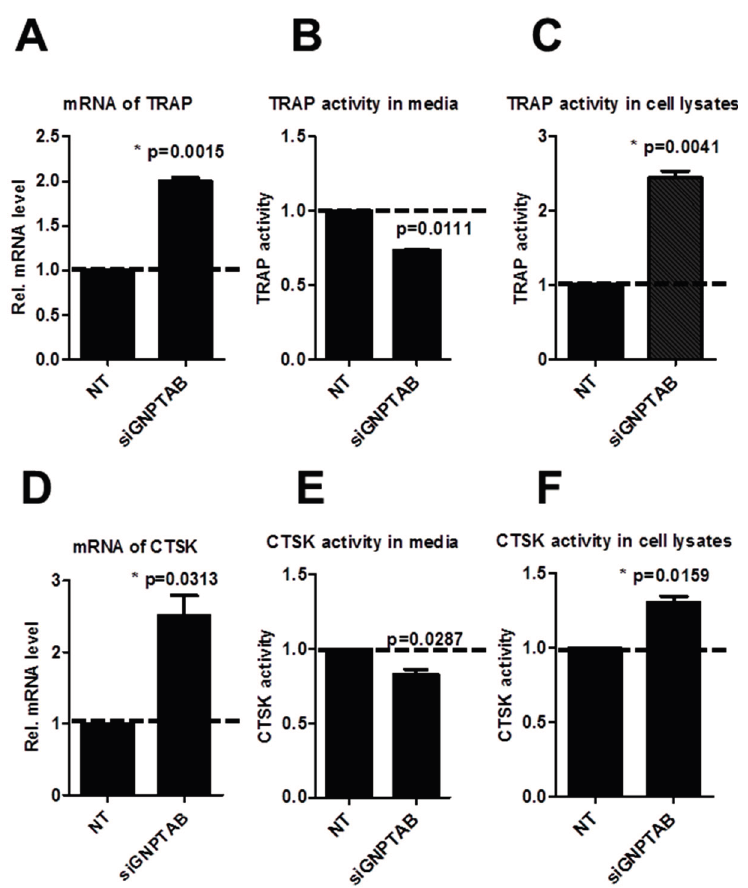
Figure 5. ( A – C ) mRNA levels of TRAP and TRAP activity in supernatant media and cell lysates ( n = 2; two technical replicates each); (D – F ) mRNA levels of CTSK and CTSK activity in supernatant media and cell lysates ( n = 2; two technical replicates